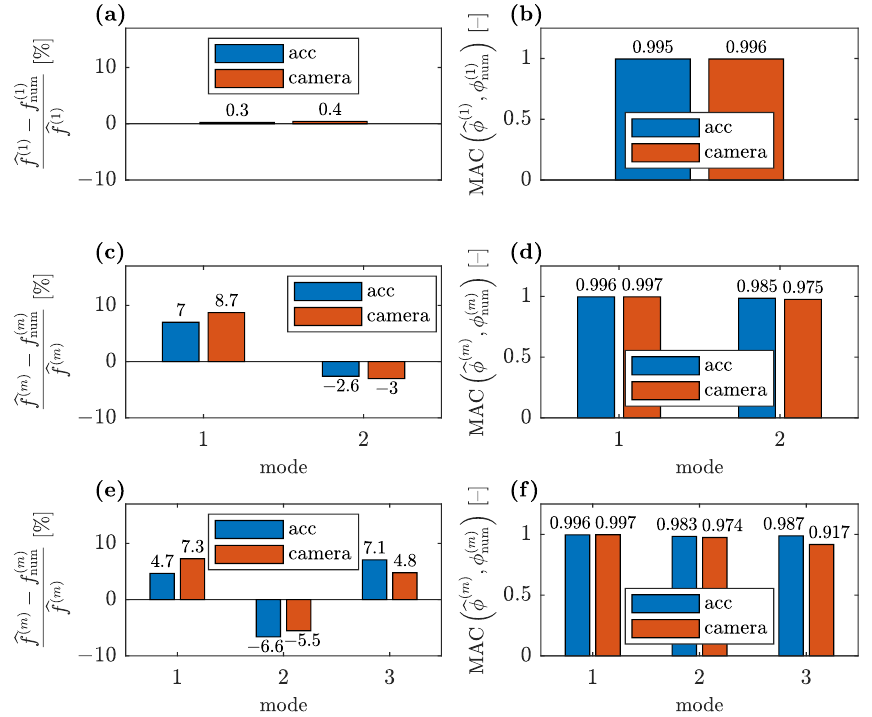
Figure 18. Comparison of the relative natural frequency error and MAC between the numerical and identified modal parameters (for parametrization with a single unknown parameter (cid:101) θ ) with the corresponding results for CV-identified modal parameters: ( a , b ) when only the first identified mode is available for model updating; ( c , d ) when two first modes are available; and ( e , f ) when all three identified modes are